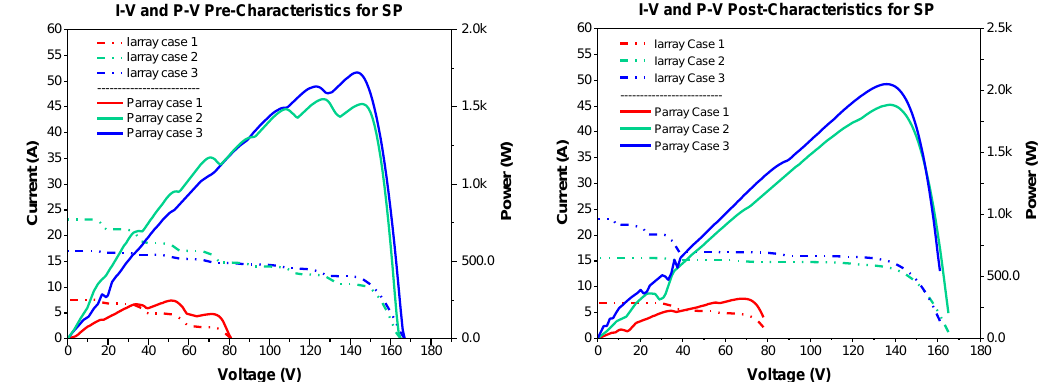
Figure 14. The outputs of a PV Arrays pre and post reconfigurations.